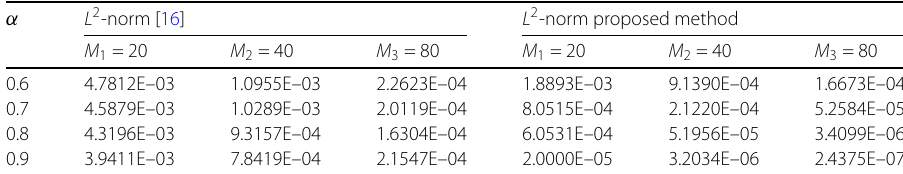
Table 2 A comparison of L 2 norm with h = 5 τ = 1 α